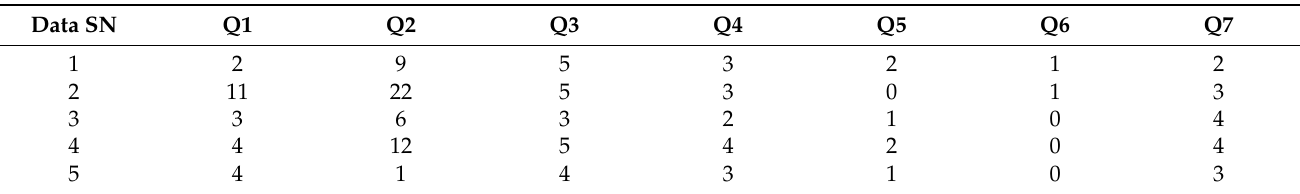
Table 4. Cleaned dataset of questionnaire answers from check-in marks. Every answer was turned to an integer for comparison using a data-cleaning process.